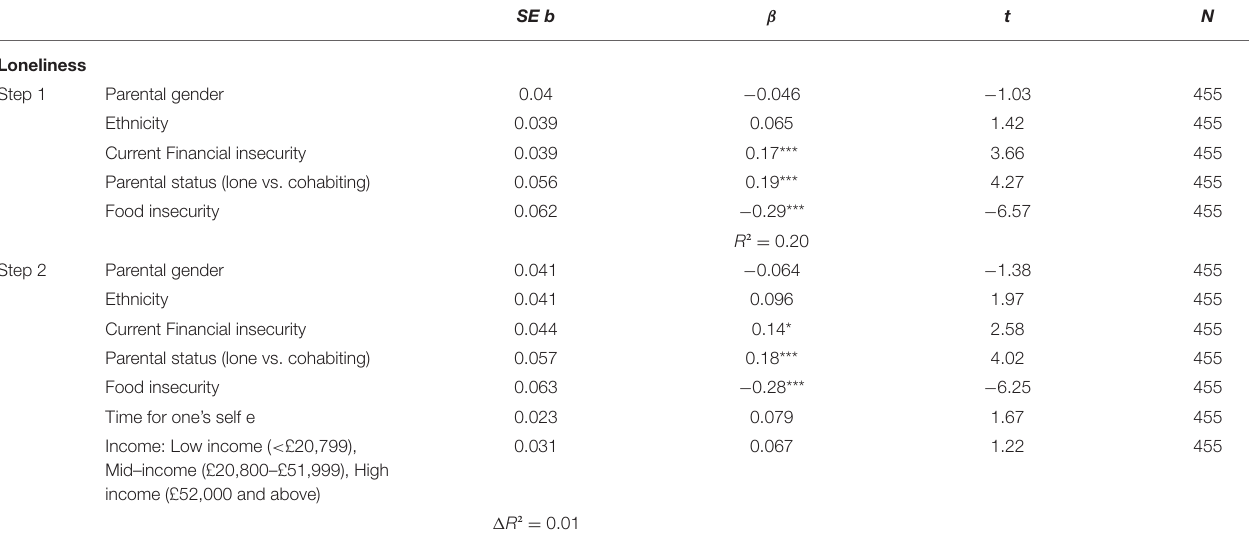
TABLE 5 | Hierarchical regression analyses predicting direct